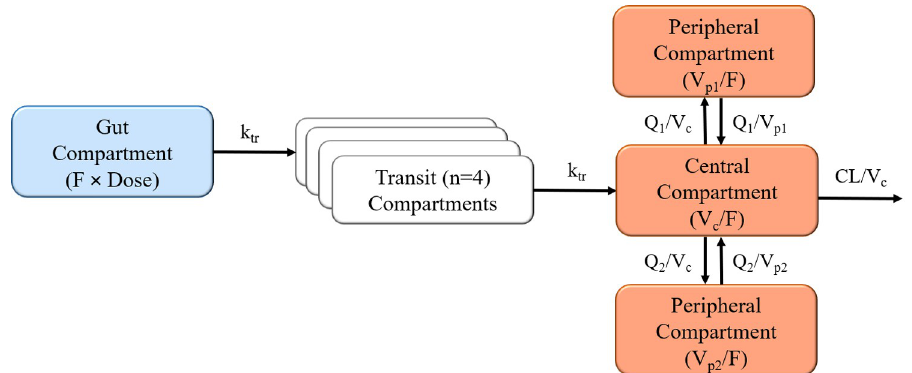
Fig 1. Graphical representation of the final structural model describing the pharmacokinetics of emodepside in healthy volunteers. Absorption from the gut compartment is described by a 4-transit-compartment absorption model, followed by a 3-compartment disposition model. F is the relative oral bioavailability, k tr is the rate constant between absorption compartments, V c is the apparent volume of distribution of the central compartment, V p is the apparent volume of distribution of the peripheral compartments, Q is the inter-compartmental clearance between the central and peripheral compartments, and CL is the apparent elimination